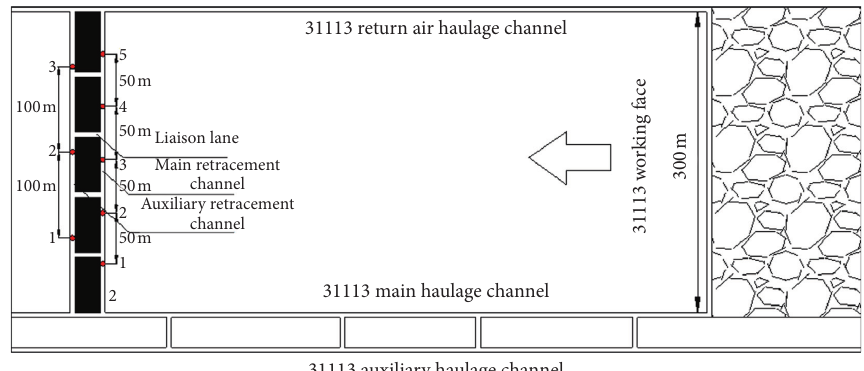
Figure 21: Schematic of the layout of surface displacement measurement points for withdrawal